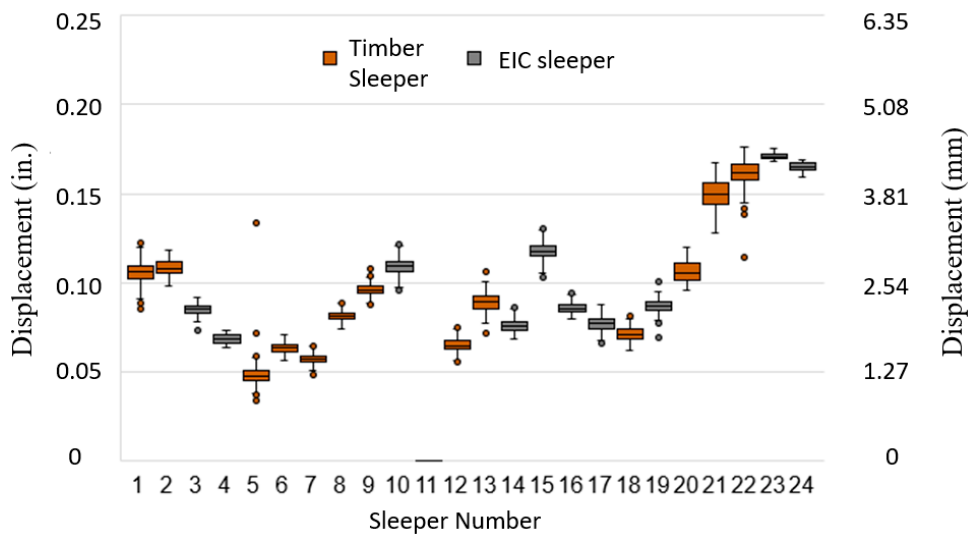
Figure 11. The displacement results for each individual sleeper (passenger coaches only).